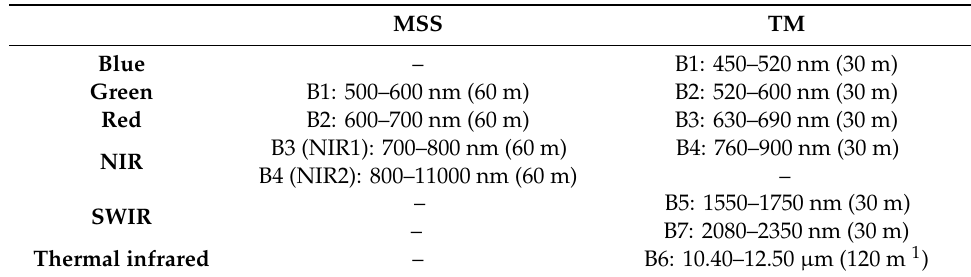
Table 1. General information about the Multispectral Scanner System (MSS) and Thematic Mapper (TM) onboard Landsat 4-5.